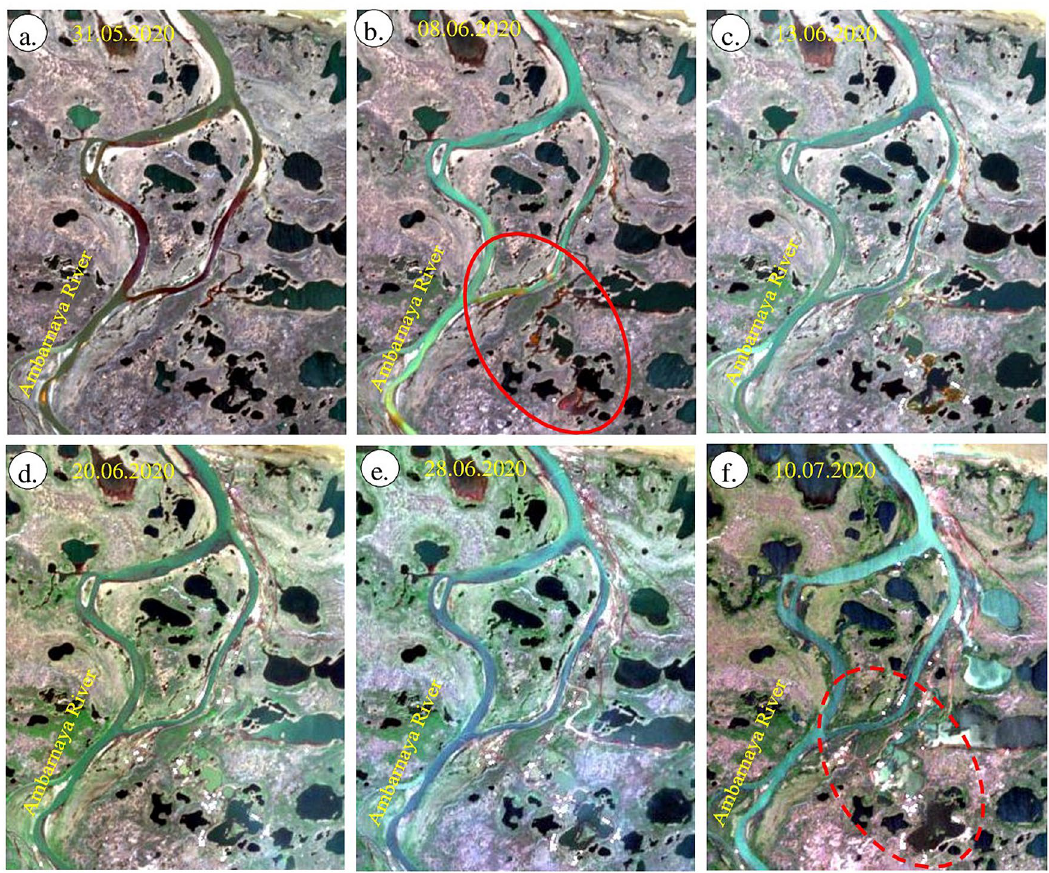
Figure 13. ( a – f ) True color images [R:4; G:3; B:2; ENVI 5.5 https ://www.harri sgeos patia l.com; https ://senti nel. esa.int/] of Sentinel-2 from May 31 to July 10, 2020, show 1) the oil spill in the Ambarnaya River and the creeks and water bodies adjacent to the river channel in the crimson red [red elliptical, 31 May and 08 June, 2020], and 2) the area of contaminated soil removed, the special containers placed to store the skimmed off oil and the toxic mix of water collected from the river [red dashed elliptical as white